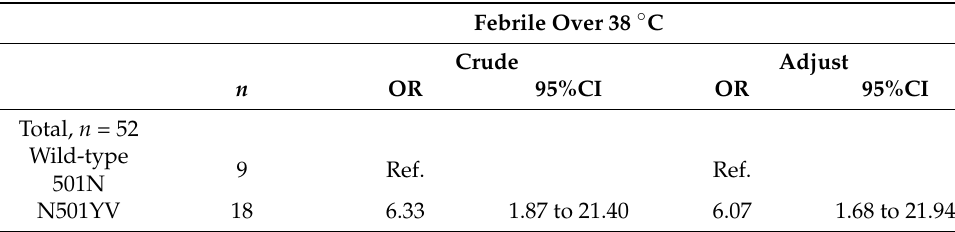
Table 4. The associations of pre-treatment symptoms between wild-type 501N and N501YV infection, using univariable and multivariable logistic regression models. ( n = 52).